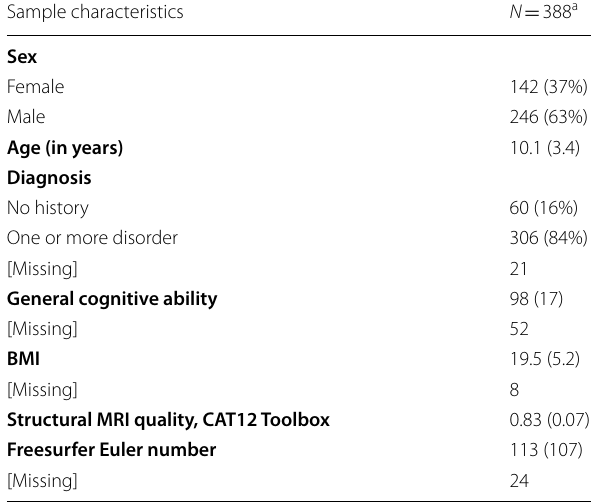
Table displaying demographic characteristics of our sample, including participant age, sex, psychiatric diagnosis (binary indicator based on structured interview), general cognitive ability, and body mass index. This table also displays the mean (and standard deviations) for our MRI quality metric of interest, CAT12 scores, as well as Freesurfer’s Euler